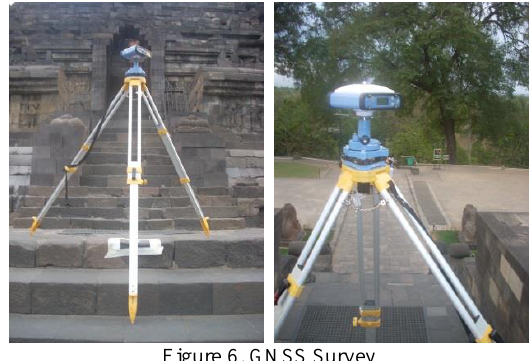
Figure 6. GNSS Survey